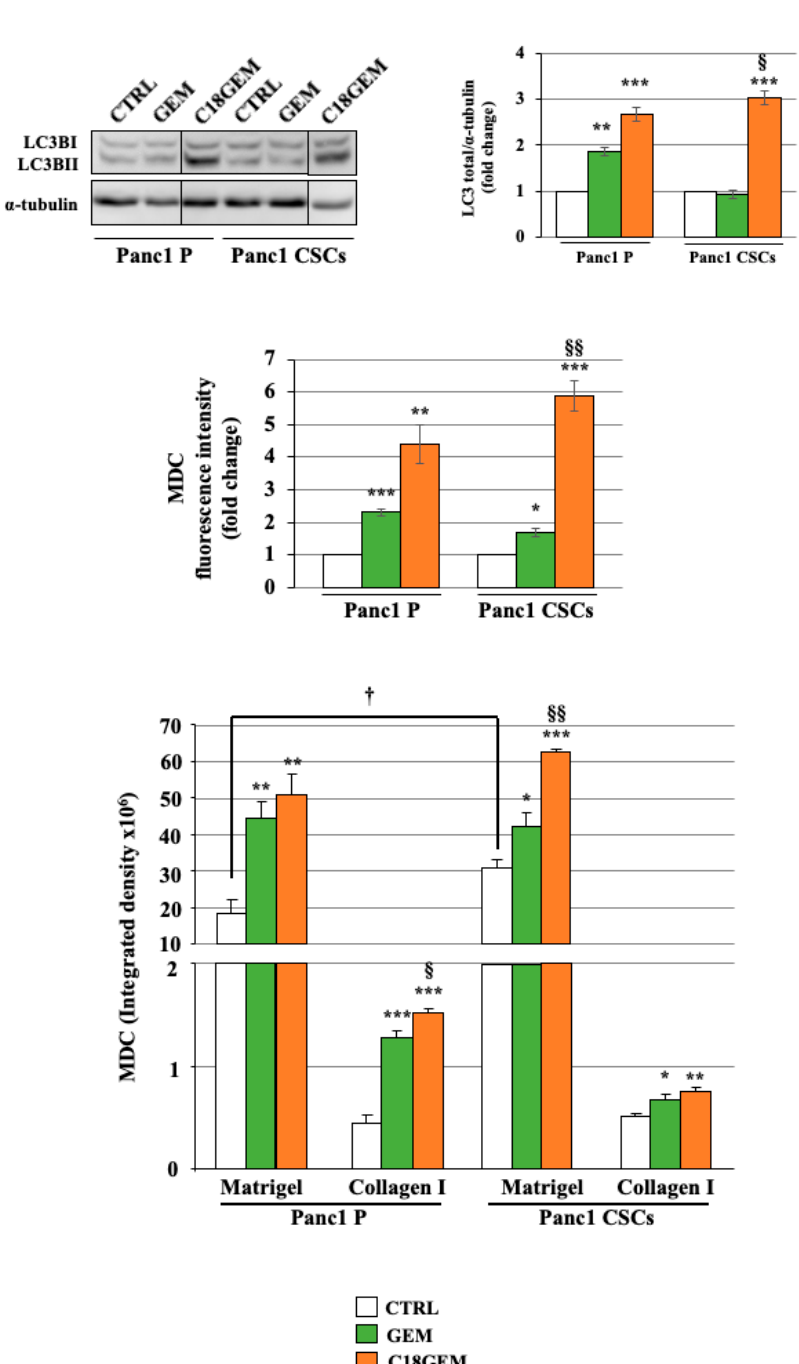
Figure 6. Induction of autophagy after GEM or C18GEM treatment in cells grown in 2D or 3D cultures. Representative Western blot analysis and quantification of LC3-II ( A ). Monodansylcadaverine (MDC) fluorescence intensity accumulated in autophagosomes of parental (P) cells and CSCs treated with 50 µ M of GEM or C18GEM for 48 h in 2D conditions ( B ) or 72 h in Matrigel- and collagen I-rich ECM ( C ). The values are reported as fold change relative to untreated cells in 2D conditions and as integrated density in 3D conditions and are the means ( ± SE) of at least three independent biological replicates. Statistical legend: p < 0.05 (*), p < 0.01 (**), or p < 0.001 (***) GEM or C18GEM versus CTRL; p < 0.05 (§), p < 0.01 (§§) C18GEM versus GEM; p < 0.05 (†) Panc1 P versus Panc1